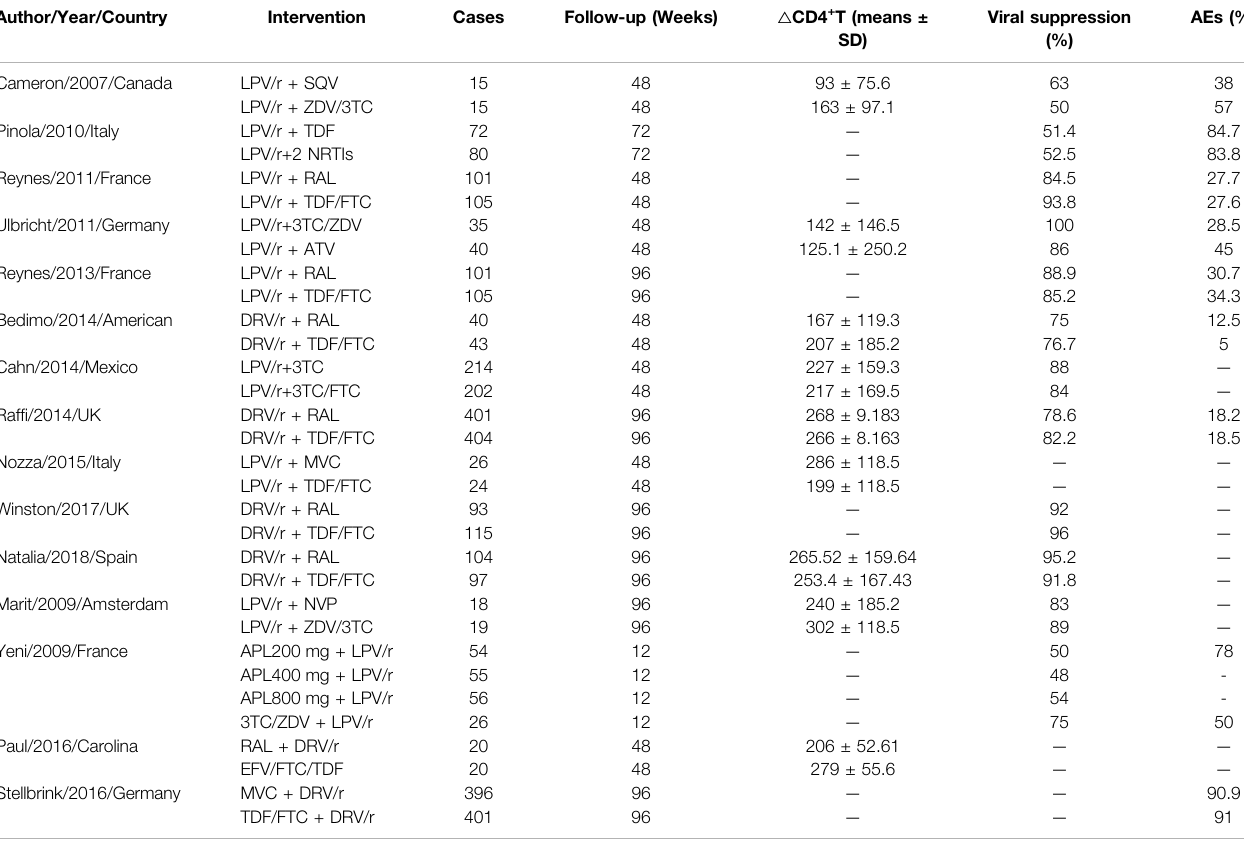
279 ± 55.6 — — Stellbrink/2016/Germany — 90.9 TDF/FTC + DRV/r 401 96 — — 91 *Adverse Events: AEs.